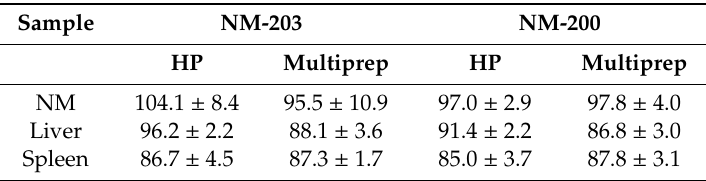
Table 3. Relative recoveries expressed as percentage for NM and target organs after closed-vessel (HP) and Multiprep oxidative digestion, calculated with Equations (1) (NM) and (2) (liver and spleen).